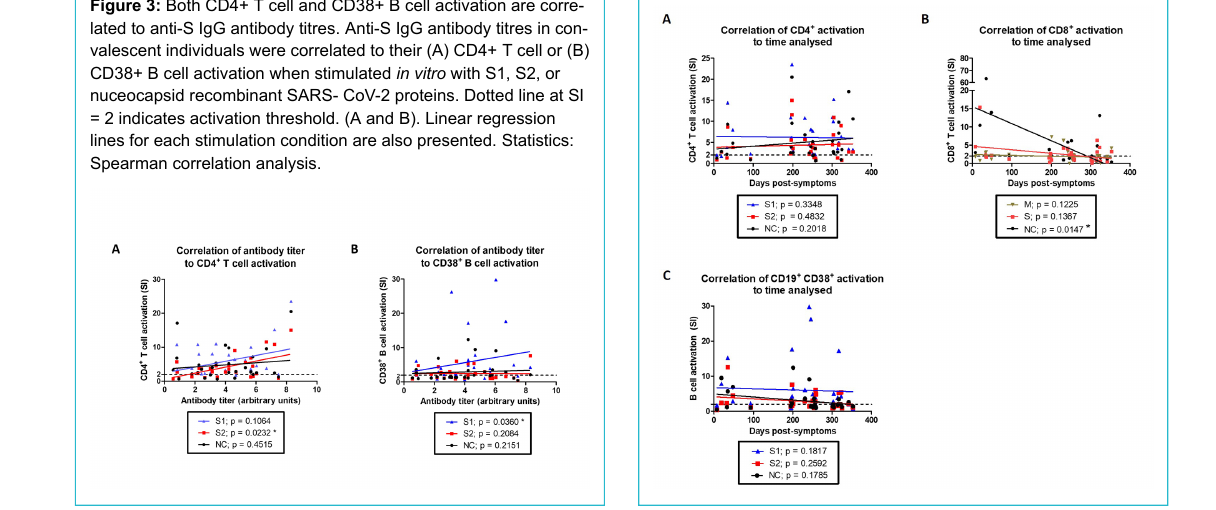
Figure 4: Decreased CD8+ memory T cell activation in later analy- ses. Time after symptoms in convalescent individuals was correlat- ed to their (A) CD4+ T cell activation when stimulated in vitro with S1, S2, or nucleocapsid recombinant SARS-CoV-2 proteins or (B) CD8+ T cell activation when stimulated in vitro with peptide mixes from membrane, S or nucleocapsid SARS-CoV-2 proteins. (C) Correlation of time after symptoms in convalescent individuals to CD19+ CD38+ B cell activation when stimulated in vitro with S1, S2 or nucleocapsid recombinant SARS-CoV-2 proteins. (A—C) Linear regression lines for each stimulation condition are also pre- sented. Statistics: Spearman correlation